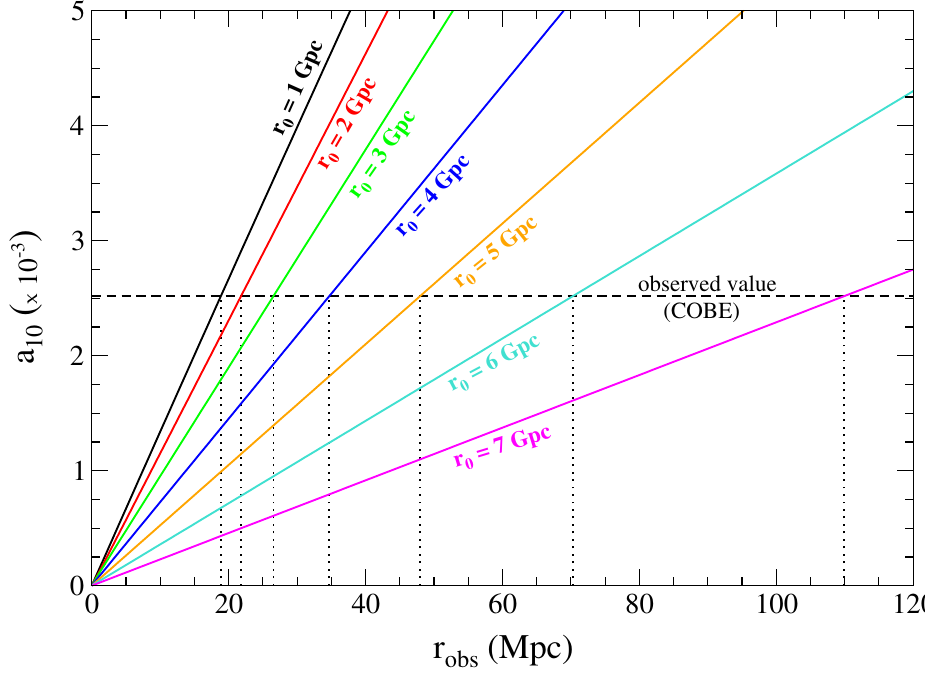
Figure 13. The predicted CMB dipole moment a of the inhomogeneity scale r uncertainty is too small to be shown (from